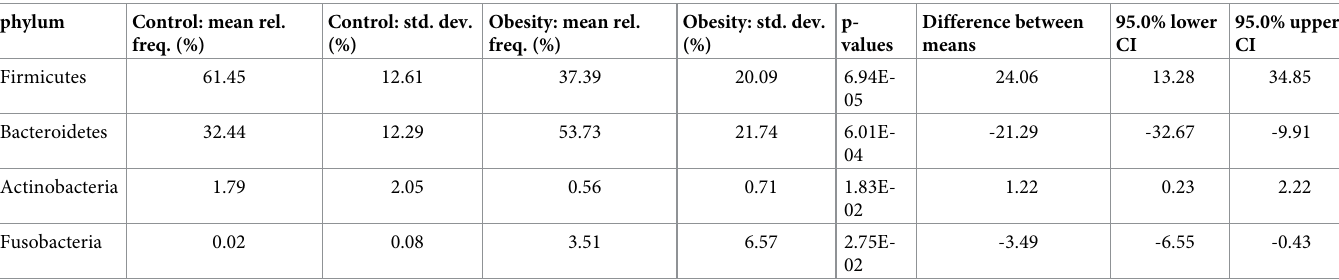
Control: std. dev. (%)